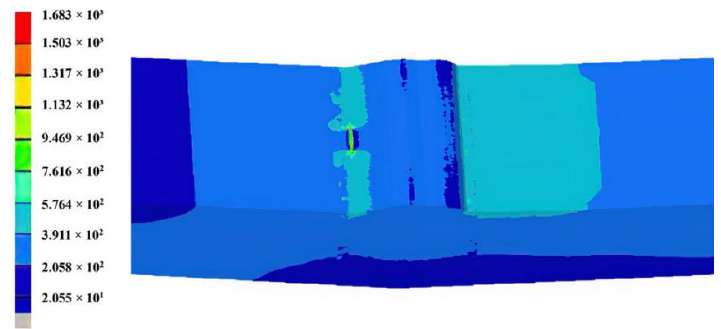
Figure 18. Equivalent stress nephogram of the whole model.